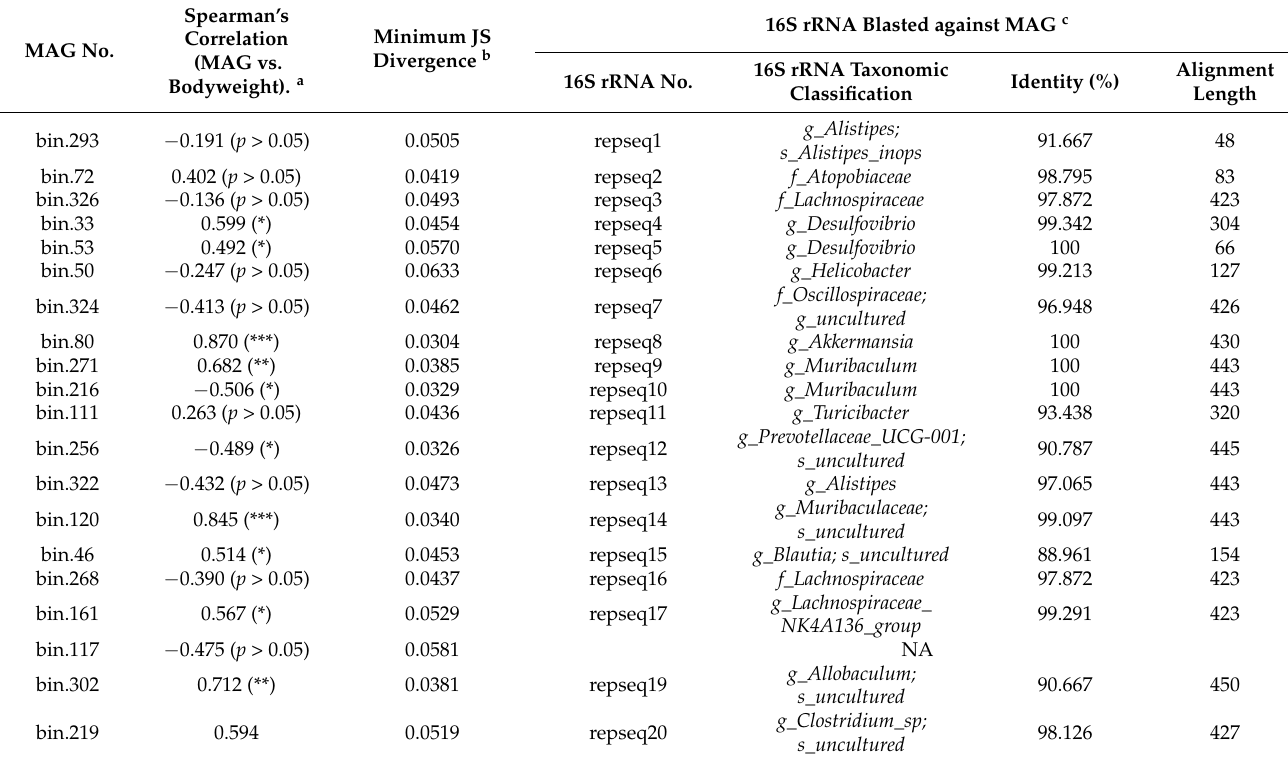
Table 1. Information (Spearman’s correlation index, fucoidan-degrading potential, and blast results) about key gut bacterial